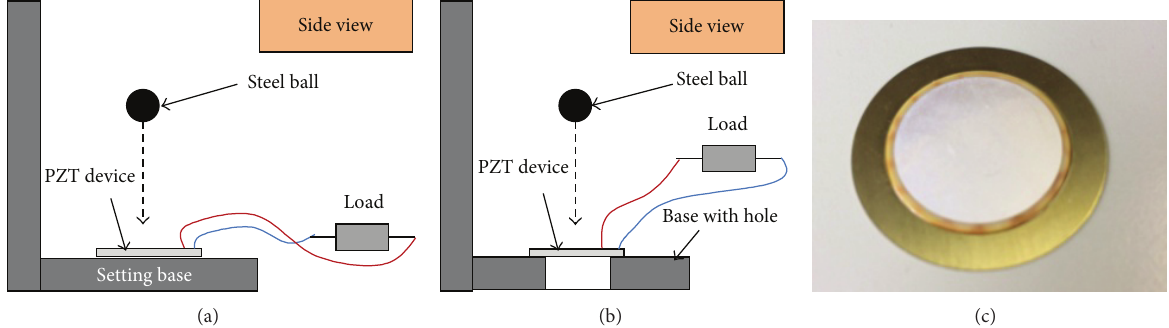
Figure 1: Experimental configuration: (a) flat base, (b) base with a hole, (c) a round piezoelectric device.